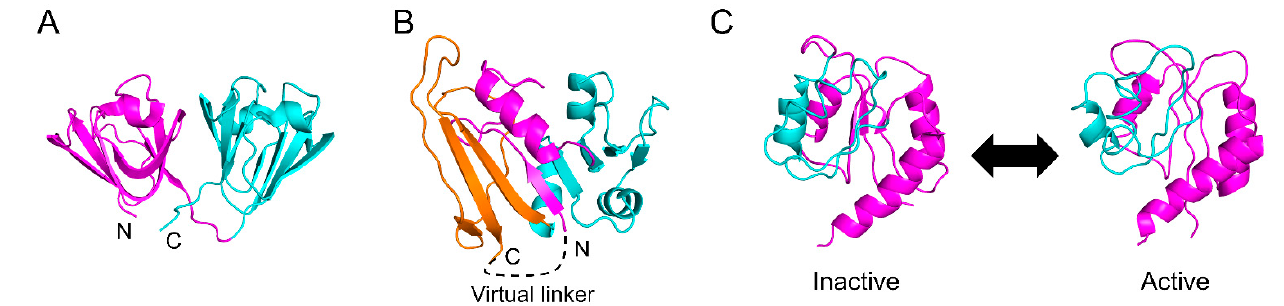
Figure 6. ( A ) Native structure of human γ D-crystallin (PDB ID: 1HK0). Domains 1 and 2 are shown in magenta and cyan, respectively. ( B ) Native structure of Escherichia coli dihydrofolate reductase (DHFR) (PDB ID: 1RX1). The N- and C-terminal parts of the discontinuous loop subdomain (DLD) are shown in magenta and orange, respectively, and the adenosine-binding subdomain (ABD) is shown in cyan. In the extended WSME (eWSME) model, a virtual linker (dashed line) was implemented to virtually connect the N- and C- termini, both of which are included in the DLD. ( C ) Inactive and active conformations of nitrogen regulatory protein C (NtrC) (PDB ID: 1DC7 and 1DC8, respectively). Phosphorylation of NtrC induces allosteric conformational changes to the residues shown in cyan. Figures were drawn using PyMOL Molecular Graphics System, Version 2.4.0 Schrödinger, LLC.